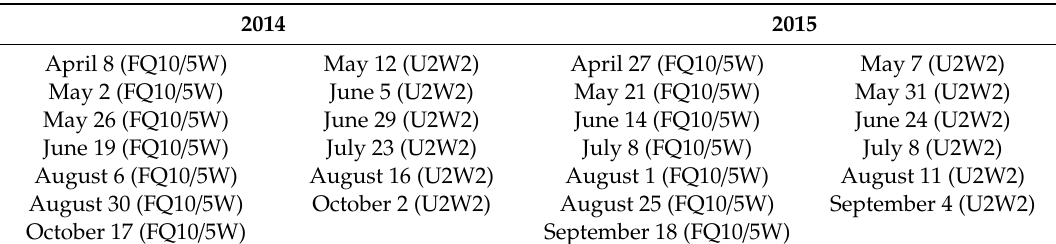
Table 3. SAR acquisition dates of Wide Ultra-Fine (U2W2) and Wide Fine-Quad (FQ10 / 5W) beam modes over PAD for 2014 and